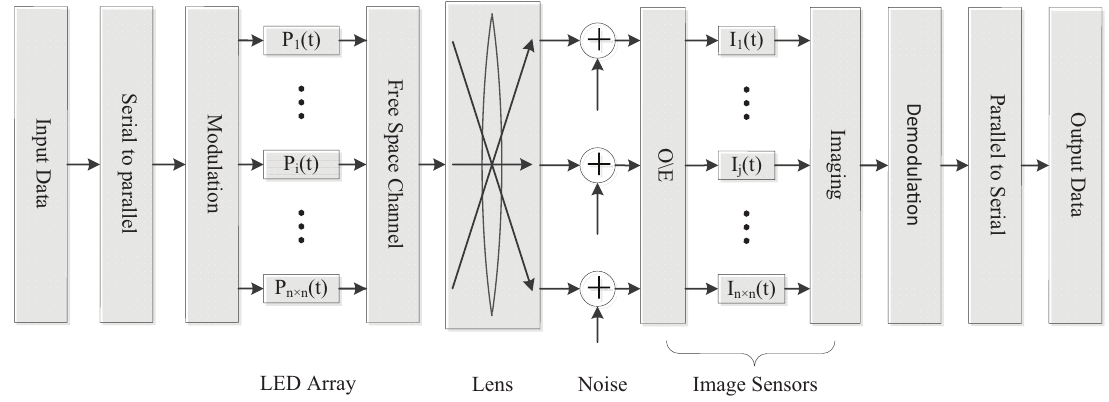
Figure 1. The block diagram of a multi-input milti-output image sensors based on visible light communication